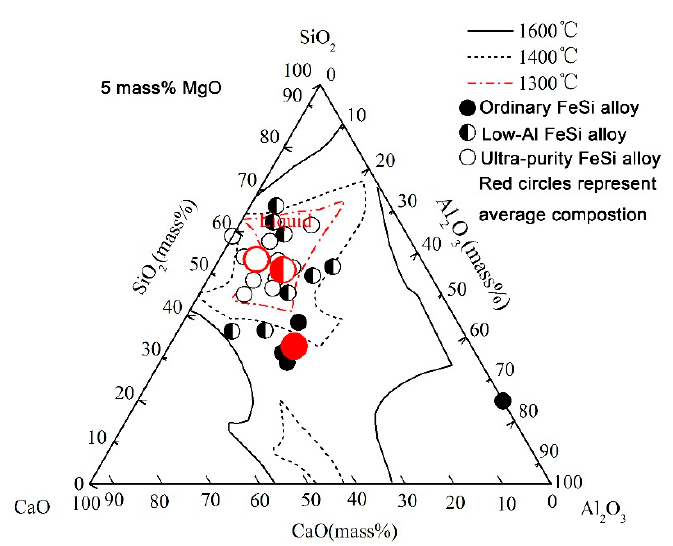
Figure 6. The composition distribution of inclusion in the samples taken at AOD tapping when using three ferrosilicon alloys on CaO-SiO 2 -Al 2 O 3 -5 mass% MgO phase diagram.